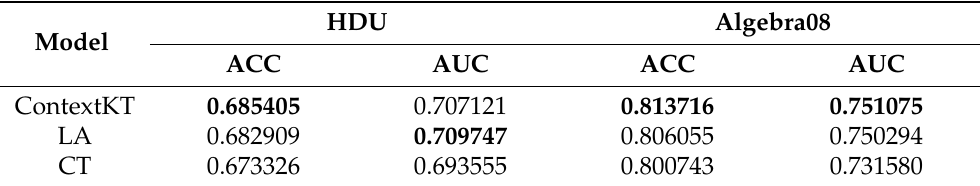
Table 4. Ablation